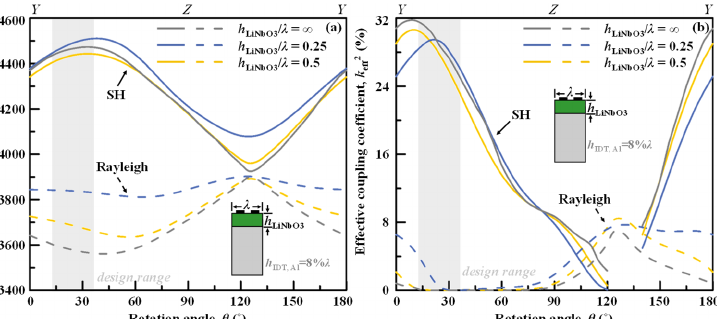
Figure 2. Simulated ( a ) open-surface phase velocities v p,o and ( b ) effective coupling coefficient k eff2 for LiNbO 3 /Si across all rotation angles from the YX -LiNbO 3 with varied thicknesses of LiNbO 3 for the SH main mode and Rayleigh spurious